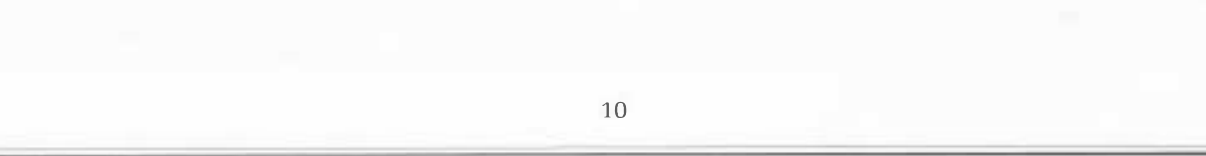
Figure 5 Plan of the Boxgrove Quarries, showing (in solid black) the location of the main excavation areas and geological test